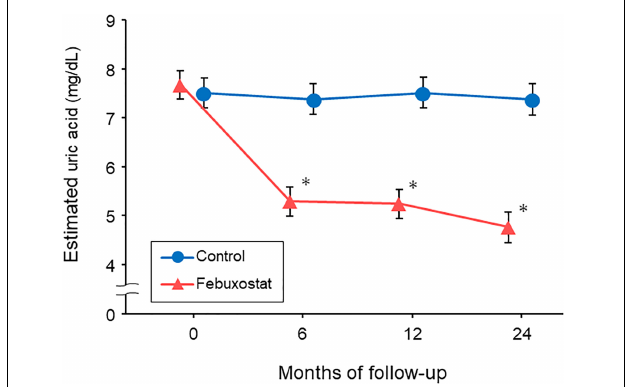
FIGURE 1 | Changes in estimated serum uric acid levels in the febuxostat group and the control group. The mixed-effects model included